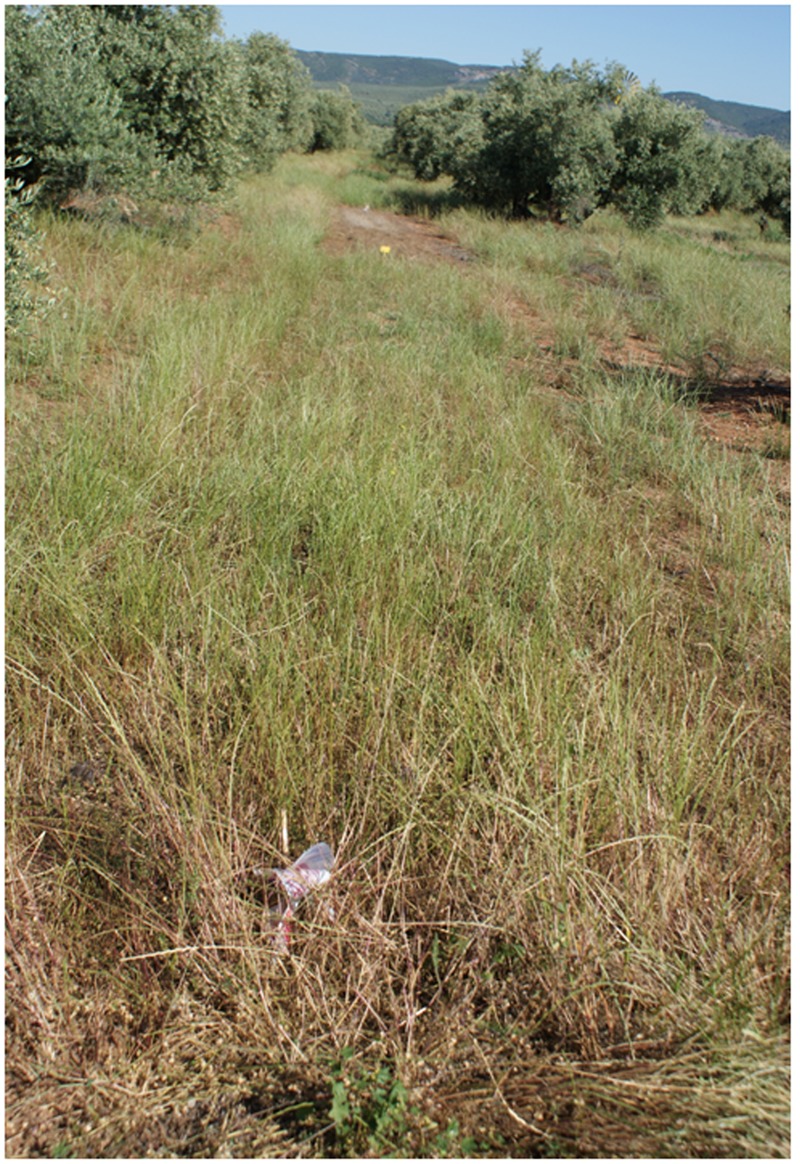
Untreated rigid ryegrass.